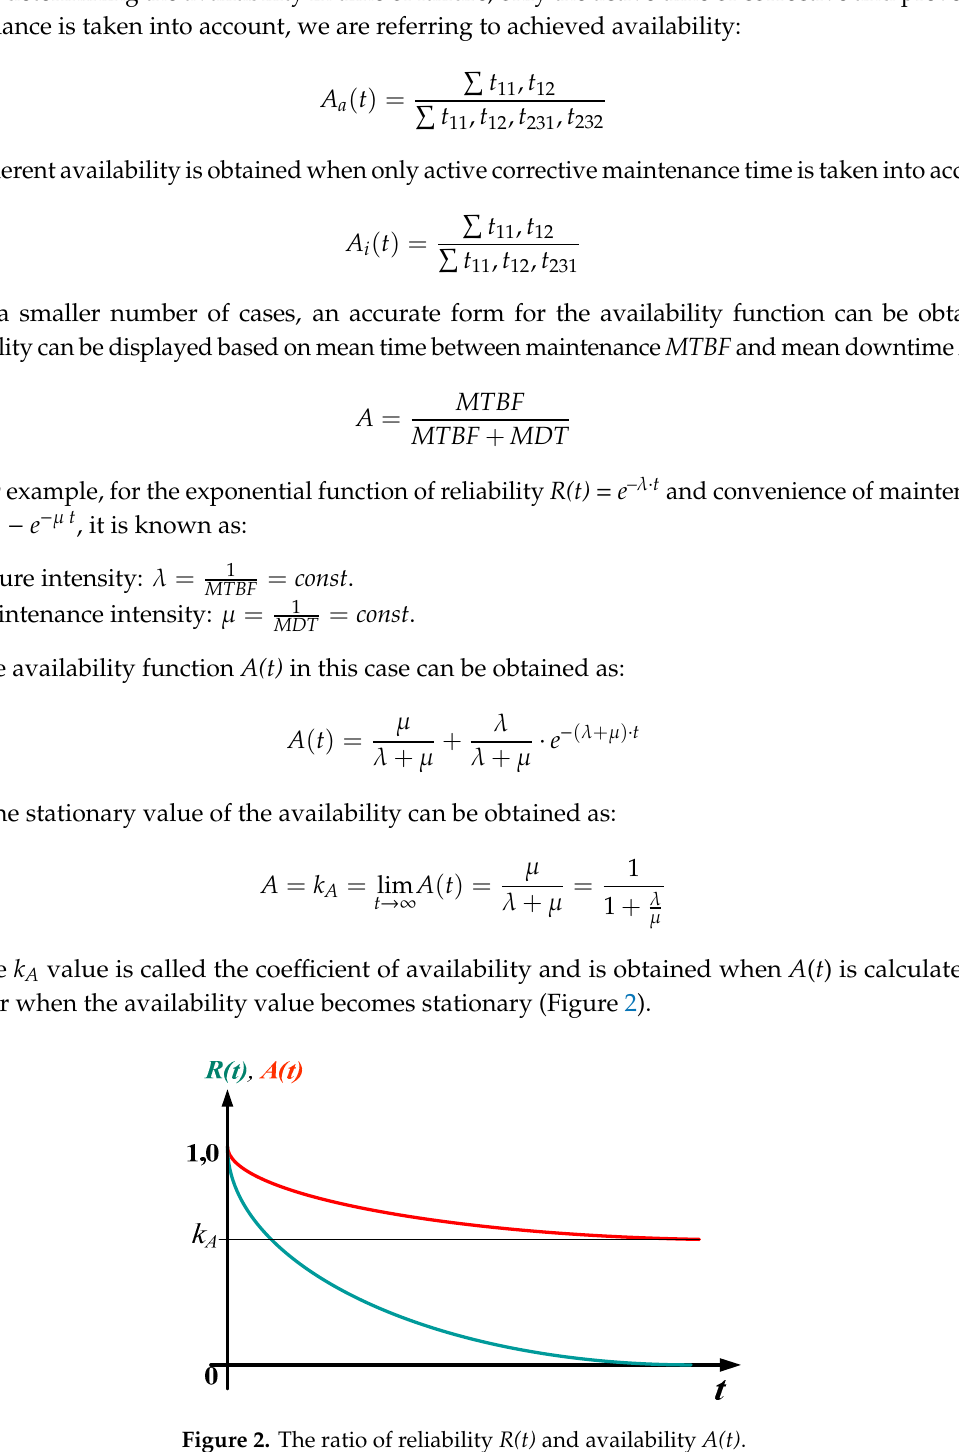
Figure 2. The ratio of reliability R(t) and availability A(t) .